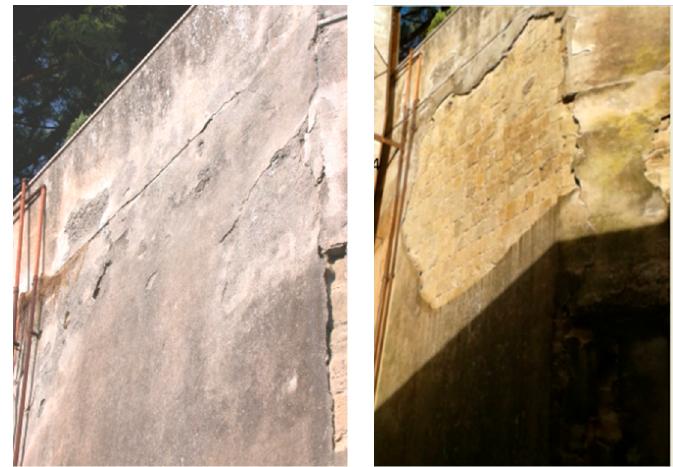
Figure 10. Retaining wall built in Neapolitan Yellow Tuff dimension stones in 1957, coated by a layer of plaster (Parco Grifeo, center of Naples). The picture on the left portrays the wall as it appeared in 2011, whereas the picture on the right portrays the same wall as it appeared in 2014 after the separation of the plaster (picture by M. de Gennaro).